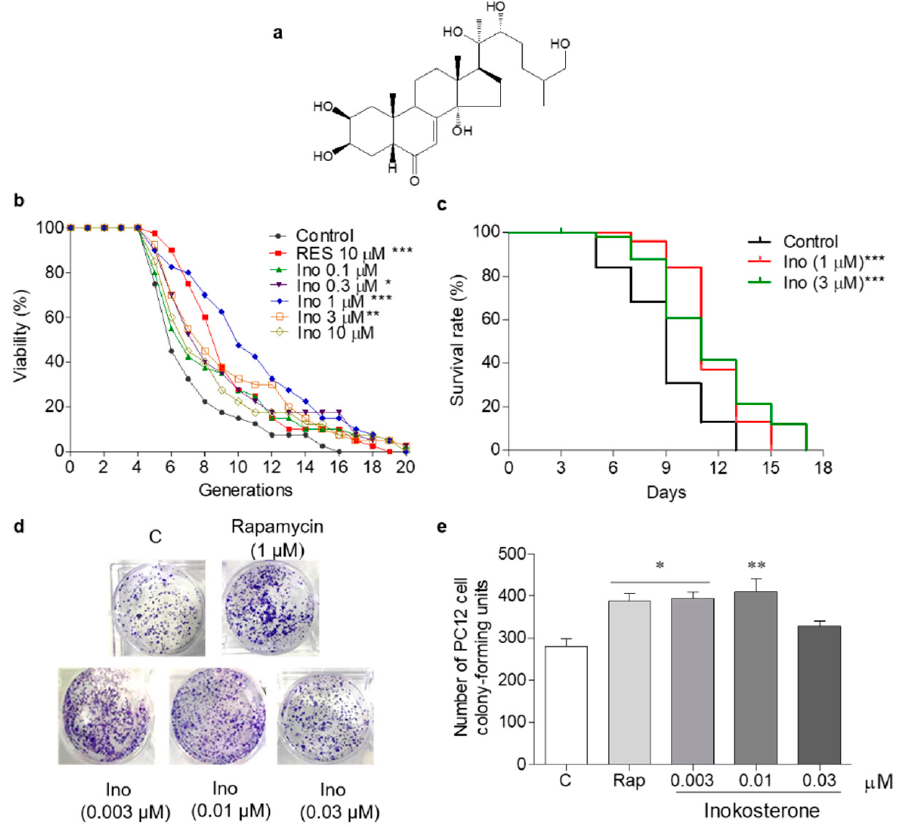
Figure 1. The chemical structure and antiaging effect of inokosterone on yeasts and mammal cells. ( a ) The chemical structure of inokosterone. ( b ) The effect of inokosterone on the replicative lifespan of K6001 yeast. The RES at 10 µ M was used as the positive control. ( c ) The effect of inokosterone on the chronological lifespan of YOM36 yeast. ( d ) The colony-forming units (CFUs) of PC12 cells after inokosterone treatment. ( e ) The digital results of ( d ). The experiments were repeated thrice, and the data are presented as the mean ± SEM. *, **, and *** represent significant differences from the control group at p < 0.05, p < 0.01, and p < 0.001, respectively.